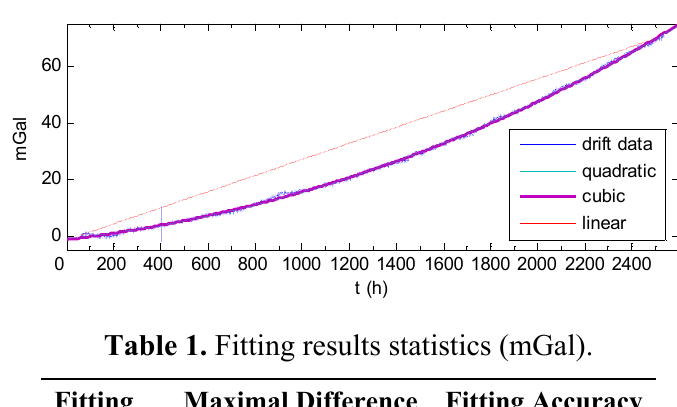
Figure 8. Curve fitting.